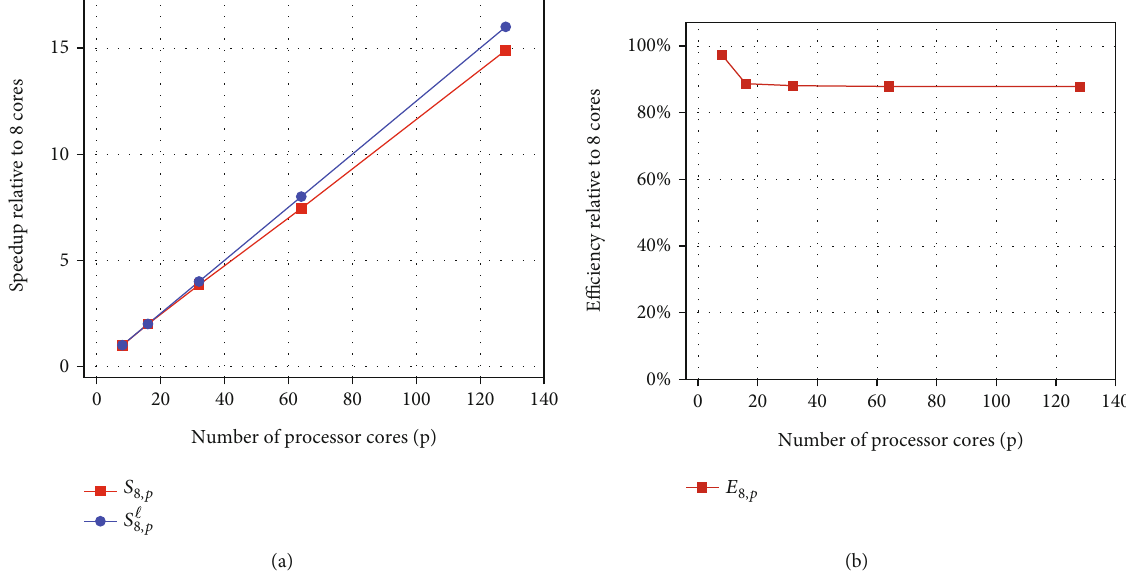
Figure 5: Strong and weak scaling analyses. (a) Strong scaling analysis. (b) Weak scaling